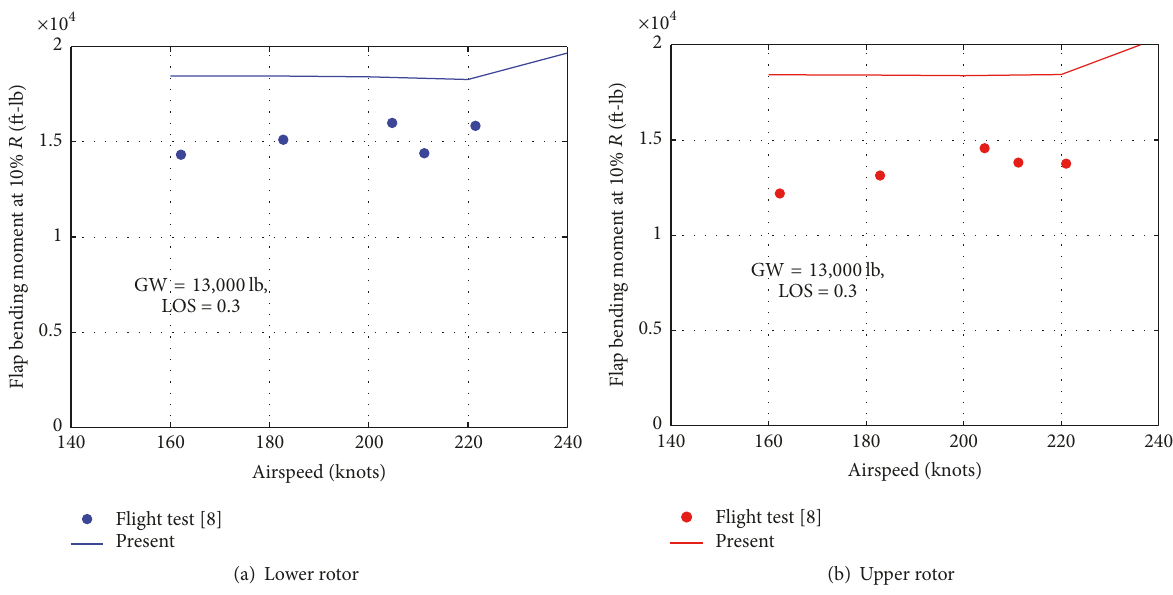
Figure 15: Validation of blade structural loads at 10% R (1/2 peak-to-peak values, compound helicopter mode).